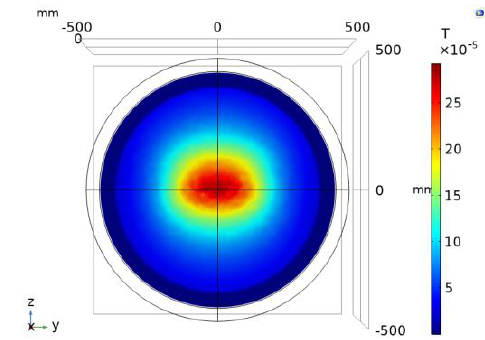
Figure 19. Square coil with seven ferrite bars on the primary side and secondary side.